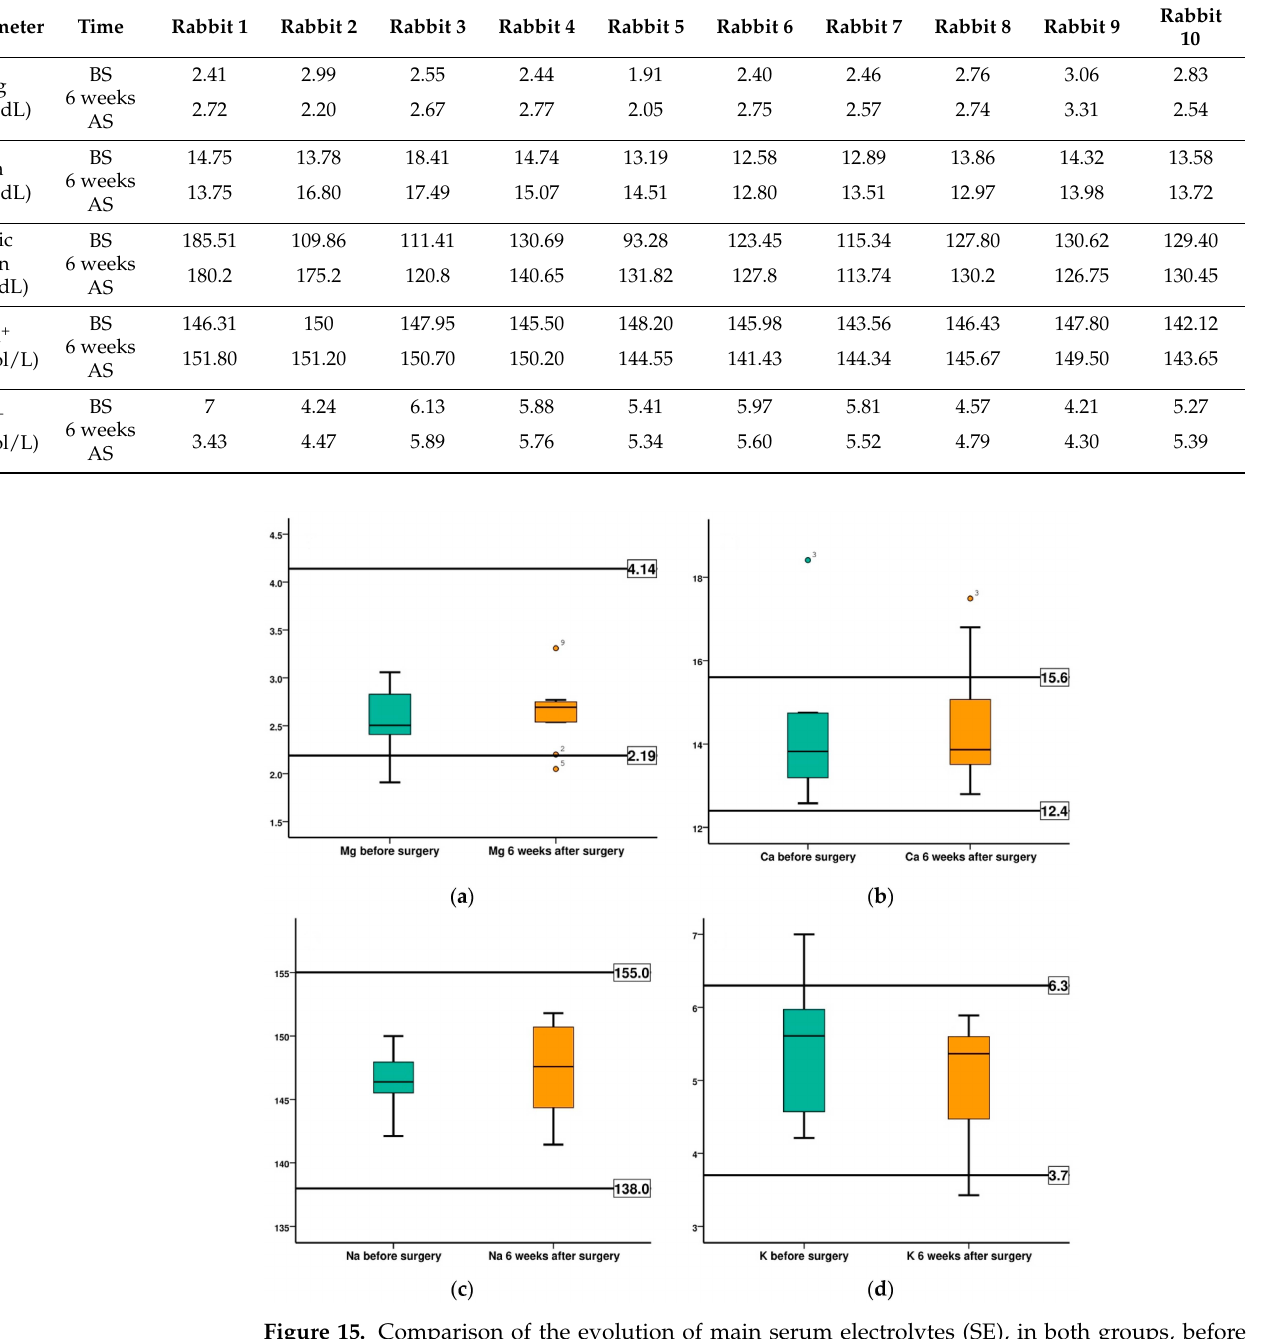
Figure 15. Comparison of the evolution of main serum electrolytes (SE), in both groups, before surgery (BS) and at 6 weeks after surgery (AS) for: ( a ) Magnesium (Mg); ( b ) Calcium (Ca); ( c ) Sodium (Na); ( d ) Potassium